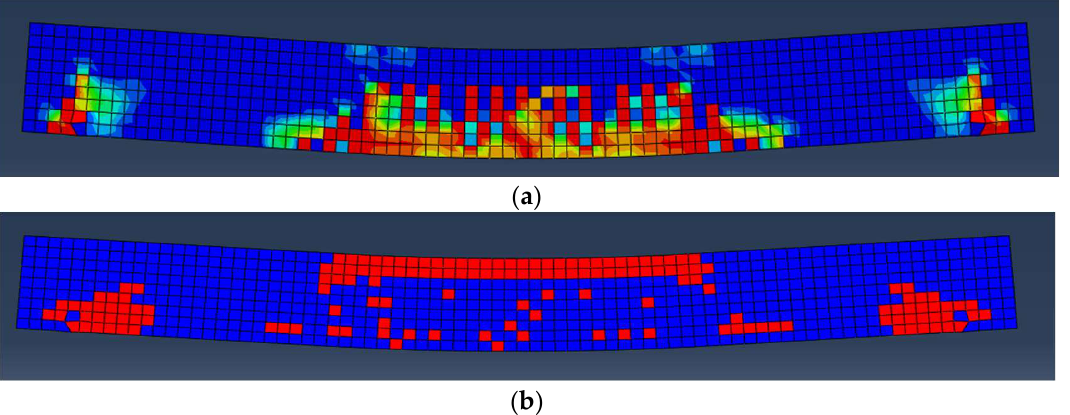
Figure 20. Analytical damage pattern of conventional concrete beam. ( a ) Tensile damage of conventional concrete beam; ( b ) Yield points of conventional concrete beam.